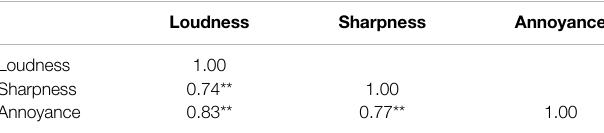
TABLE 2 | Correlation coef fi cients among subjective loudness, annoyance, and